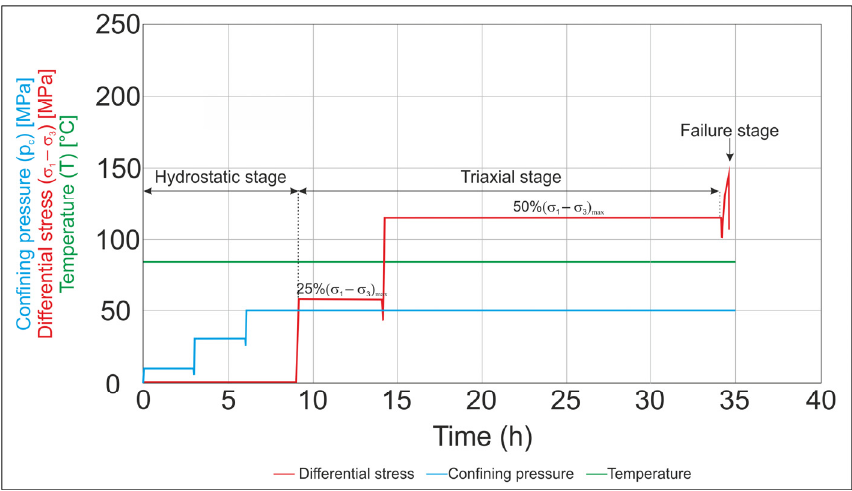
Figure 6. Schematic diagram of the viscoelastic creep test (VCT).